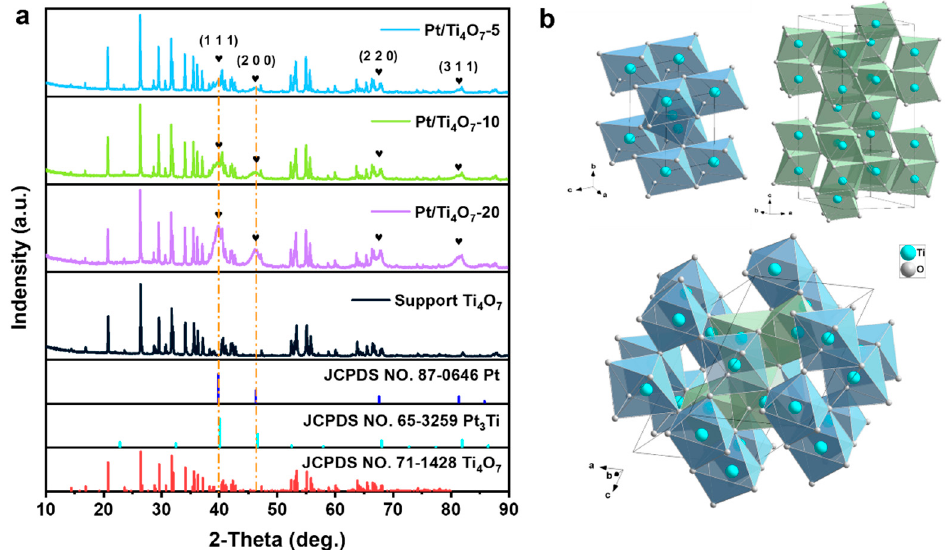
Figure 3. ( a ) XRD patterns of Pt/Ti 4 O 7 catalysts with different Pt loading levels; ( b ) Crystalline structure of TiO 2 of rutile structure (left), Ti 2 O 3 of corundum structure (right), and Ti 4 O 7 Magnéli phase (down).